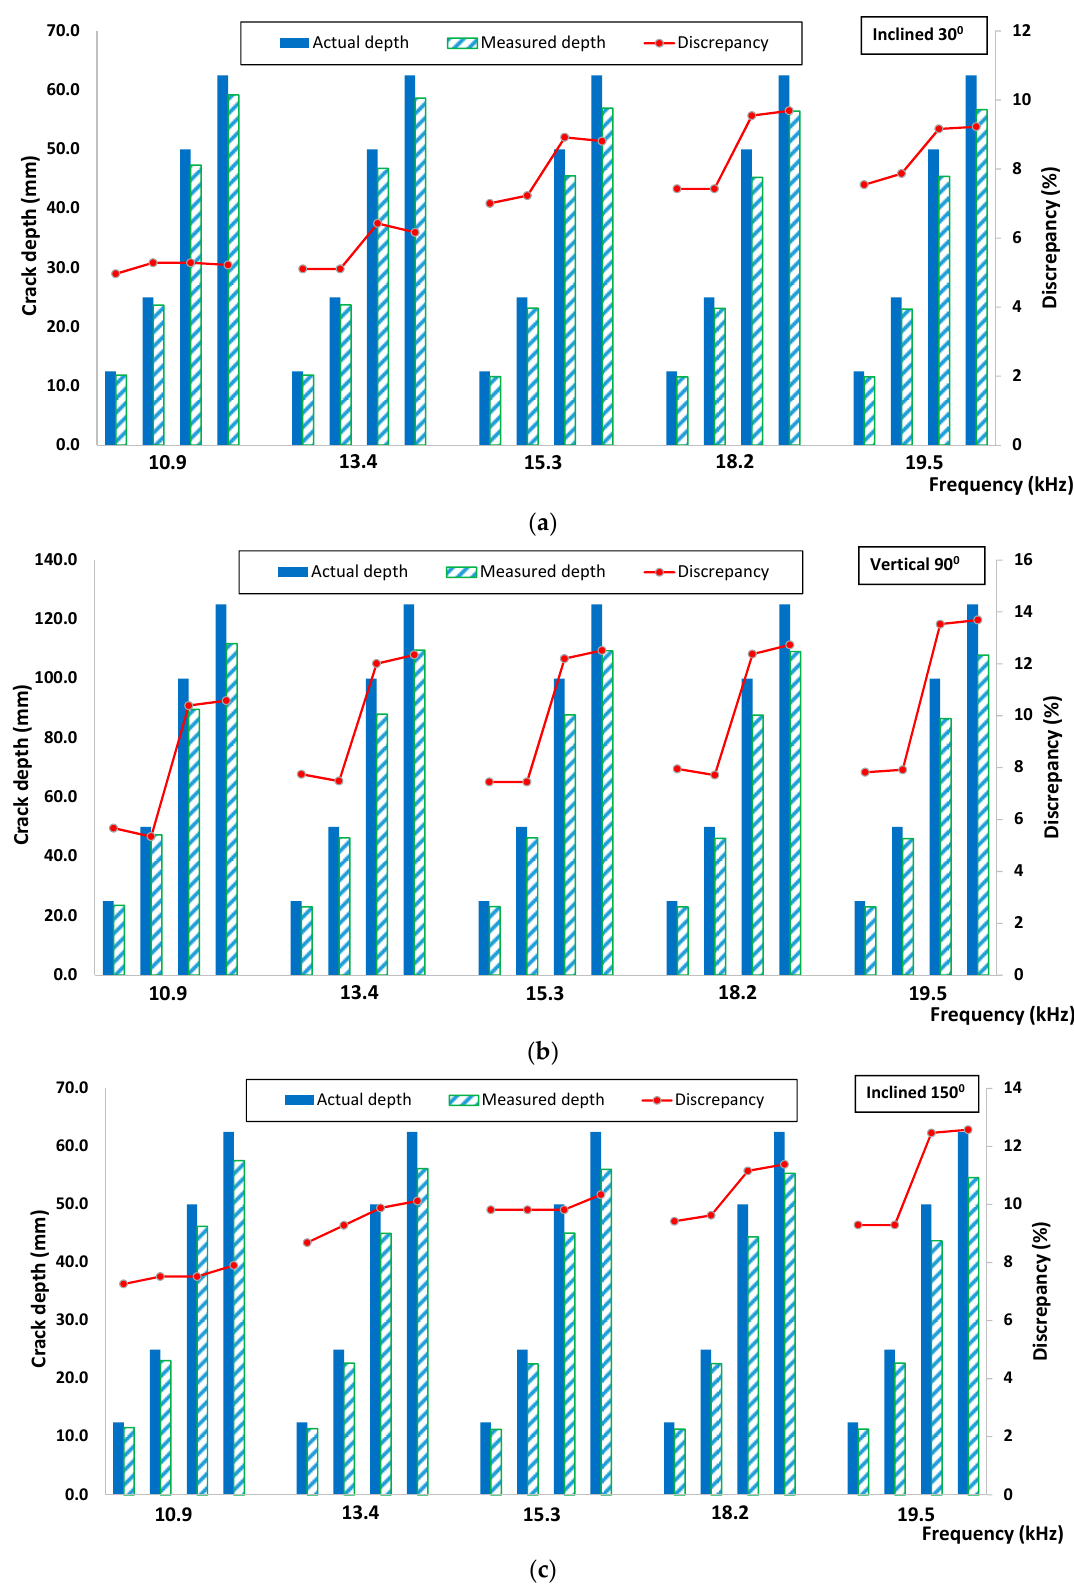
Figure 14. Comparison between actual and experiment measured crack depth based on amplitude index for ( a ) inclined 30°; ( b ) vertical 90°; ( c ) inclined 150°.